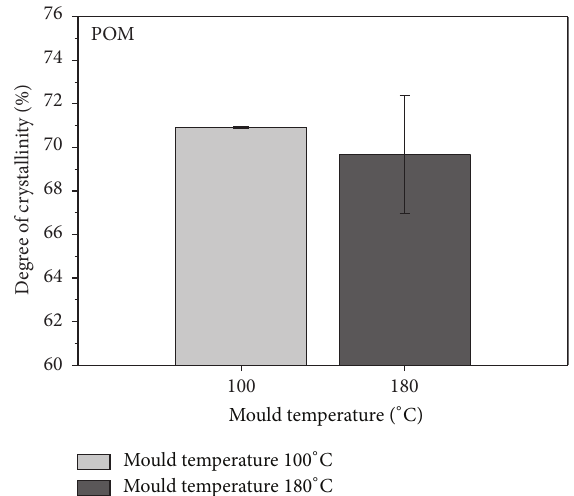
Figure 6: Degree of crystallinity in POM tensile bars with respect to mould temperature.